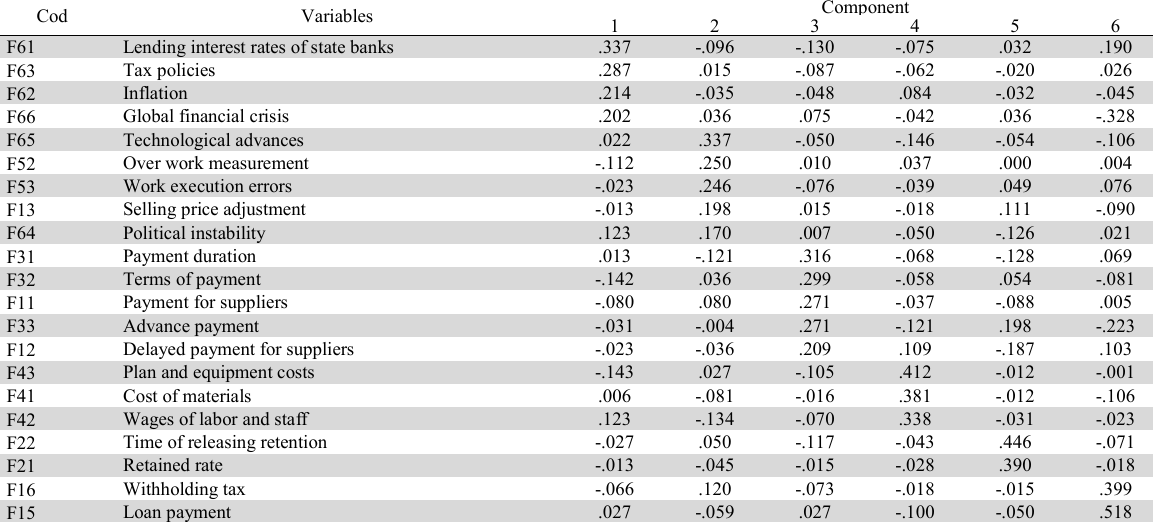
Component Score Coefficient